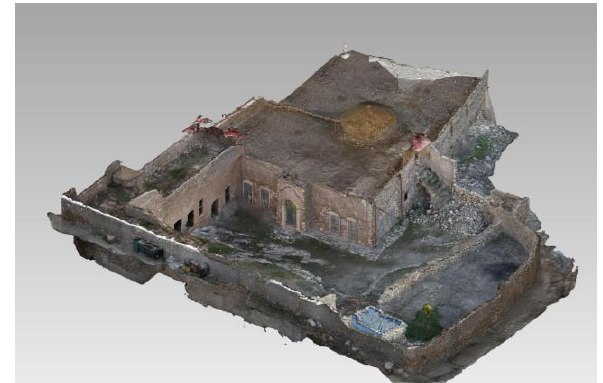
Figure 8. Sample of a textured model created from photogrammetric data set; view from the North